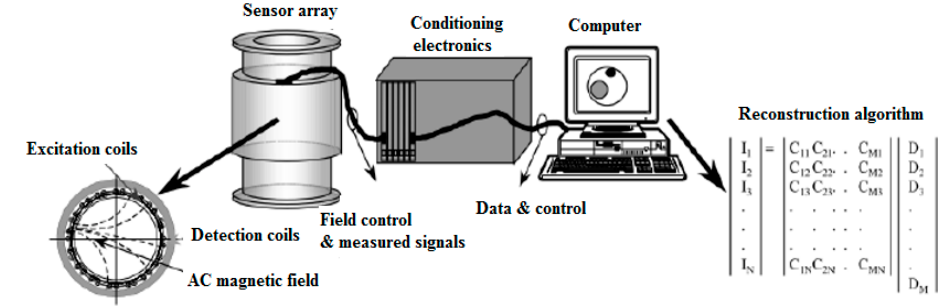
Figure 1. Diagram of magnetic induction tomography system [85].